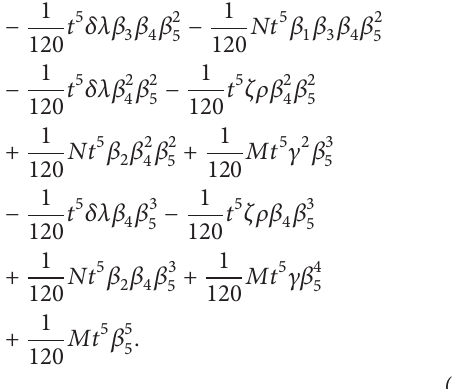
Figure 3: Numerical solution of the